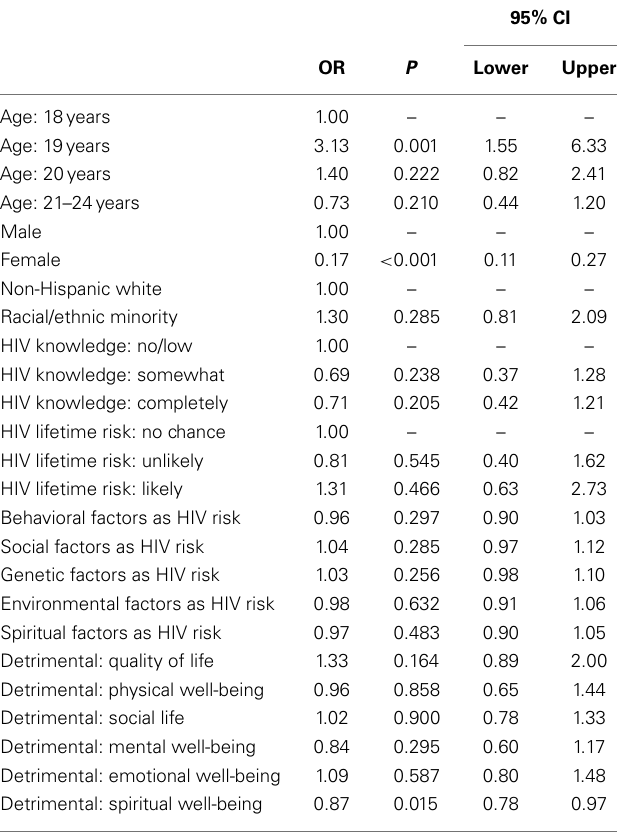
Table 4 | Factors associated with STEM academic majors